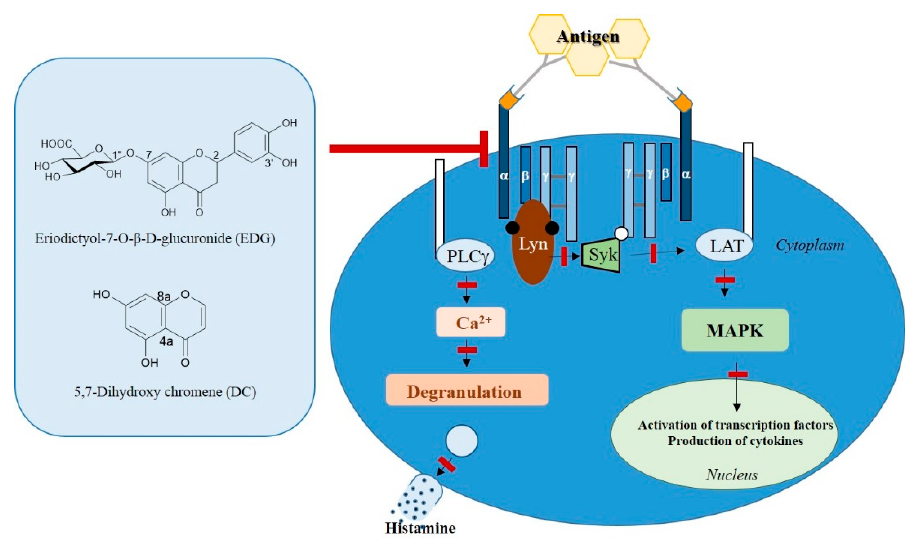
ff ects of EDG and DC on Fc ε RI-mediated signaling pathway in KU812F Figure 7. Effects of EDG and DC on Fc ε RI-mediated signaling pathway in KU812F cells. Figure 7. E